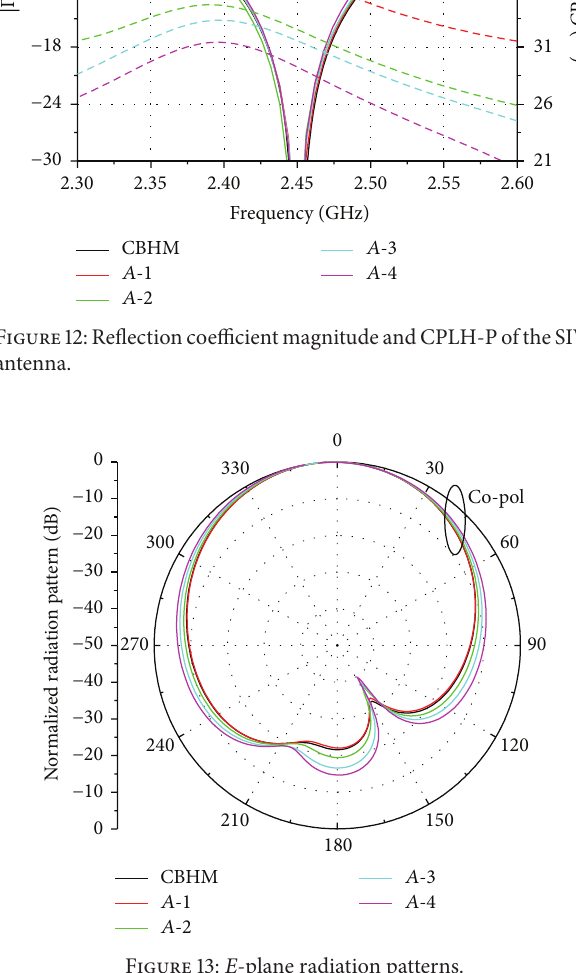
Figure 13: E -plane radiation